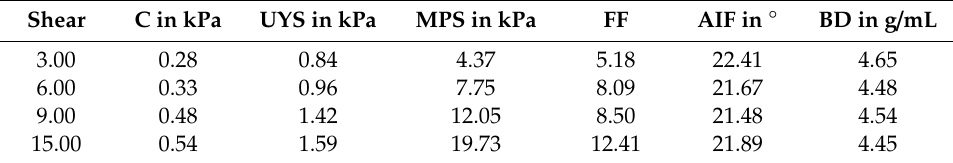
Table 7. Results of the shear tests for Metcoclad